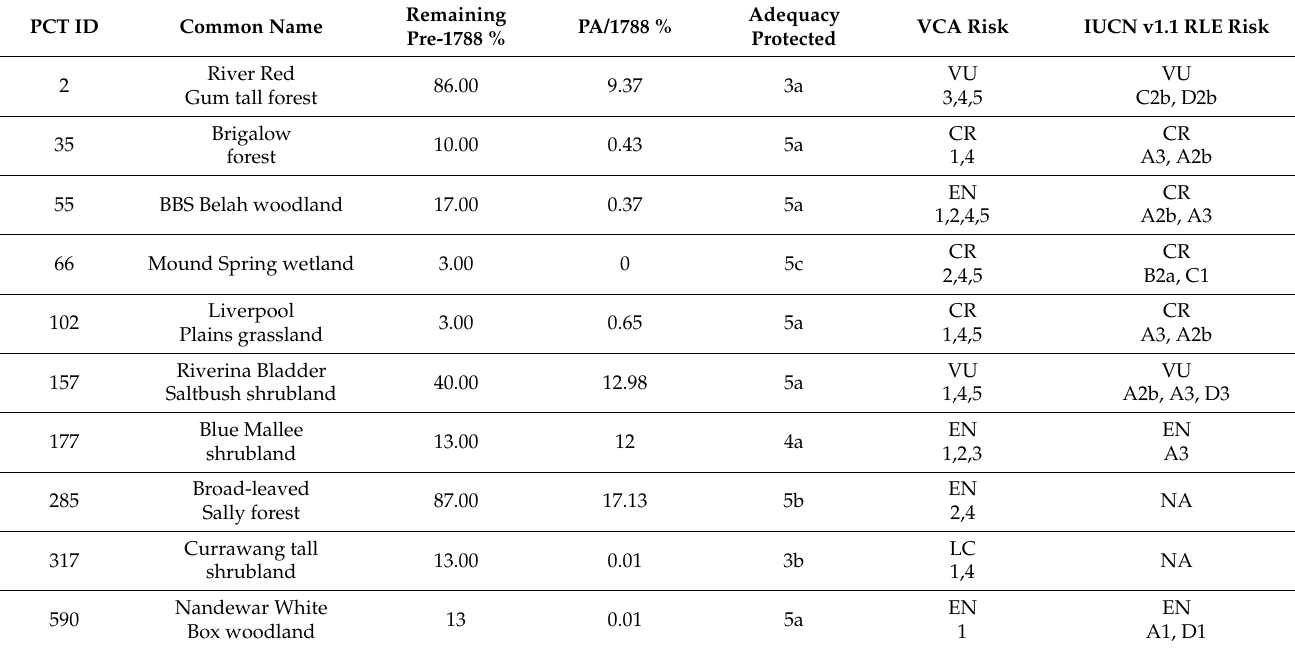
Table 2. Comparison of risk categories applying NSWVCA [8] and IUCN Red List of Ecosystemsv1.1 [20] criteria for ten structurally different inland NSW Plant Community Types. Protected area (PA) codes are defined in Supplementary Materials S1.